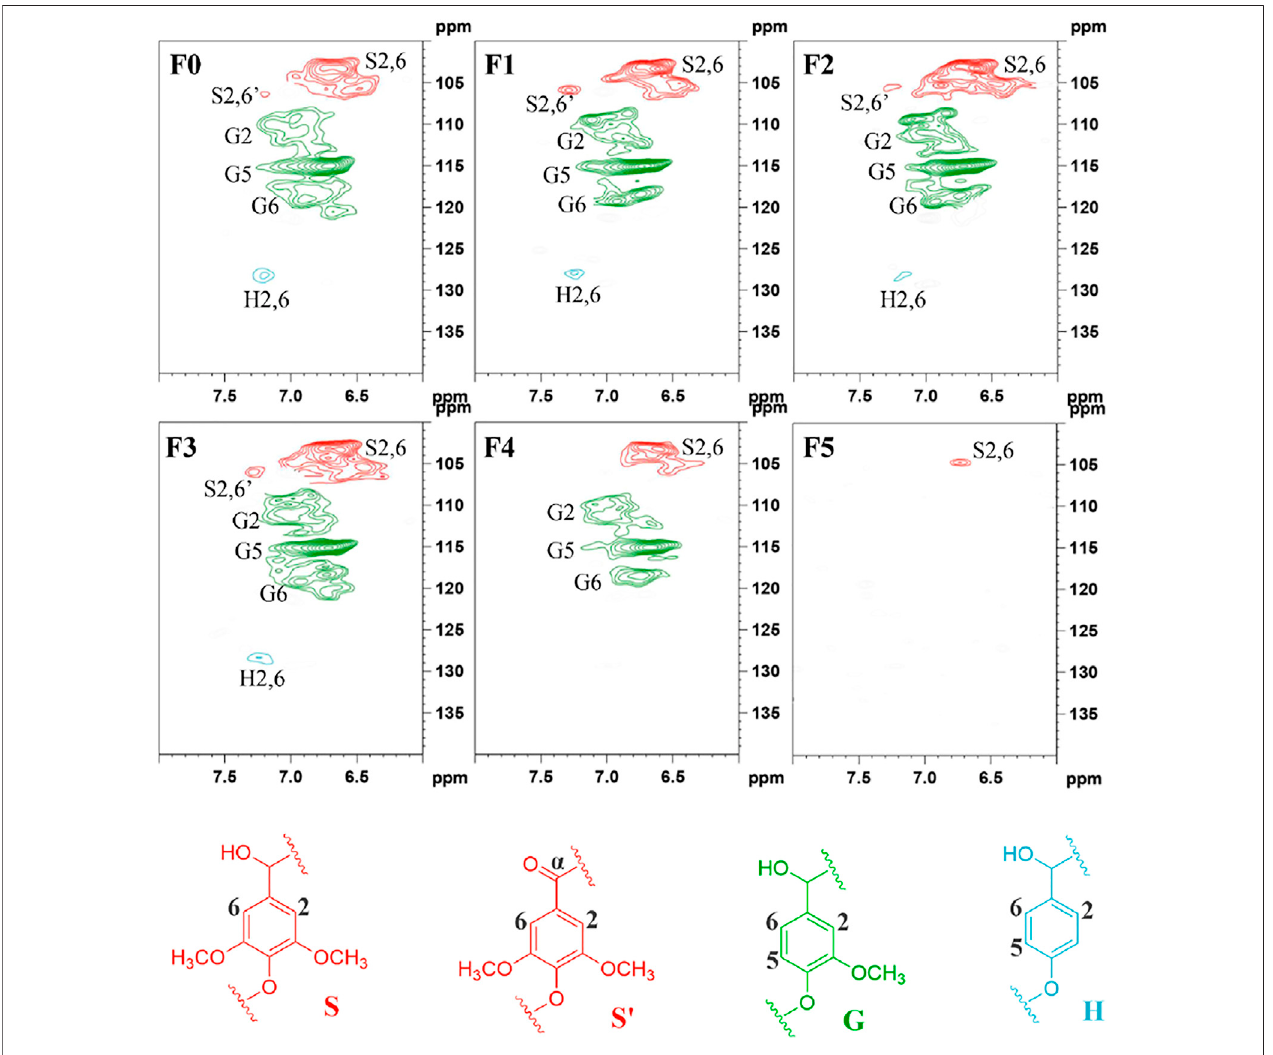
FIGURE 4 | The aromatic ring of lignin samples in the 2D HSQC NMR spectra.